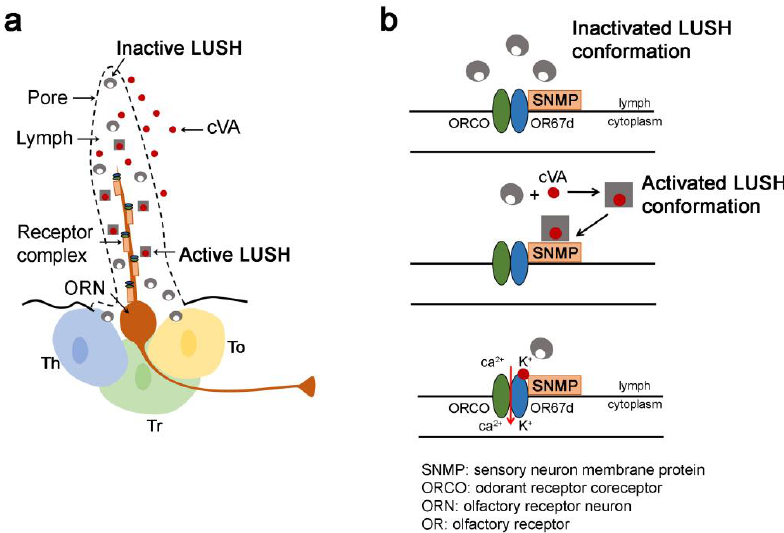
Figure 6. Model of the mechanism of the conformational activation of LUSH leading to cis -Vaccenyl Acetate (cVA) pheromone detection. ( a ) Schematic drawing of at1 cVA-sensing trichoid sensillum. This sensillum is punctured by multiple pores and houses one olfactory receptor neuron (ORN). The heteromeric complex composed of the OR67d pheromone receptor/ORCO coreceptor and the CD36-related sensory neuron membrane protein (SNMP) is localized on the ORN dendrite. Three accessory cells, trichogen (Tr), thecogen (Th) and tormogen (To) cells, surround the cell body of the ORN. Thecogen and the tormogen cells both secrete sensillar lymph components, including OBPs. ( b ) Top: in the absence of the cVA pheromone, LUSH is in an inactive state, and when bound to cVA, LUSH undergoes a conformational change. Middle and bottom: subsequently, direct or indirect interaction of “cVA/LUSH” with SNMP1 induces the release and transfer of cVA to the ligand-binding site within the OR67d/ORCO complex. Adapted from [121,122].